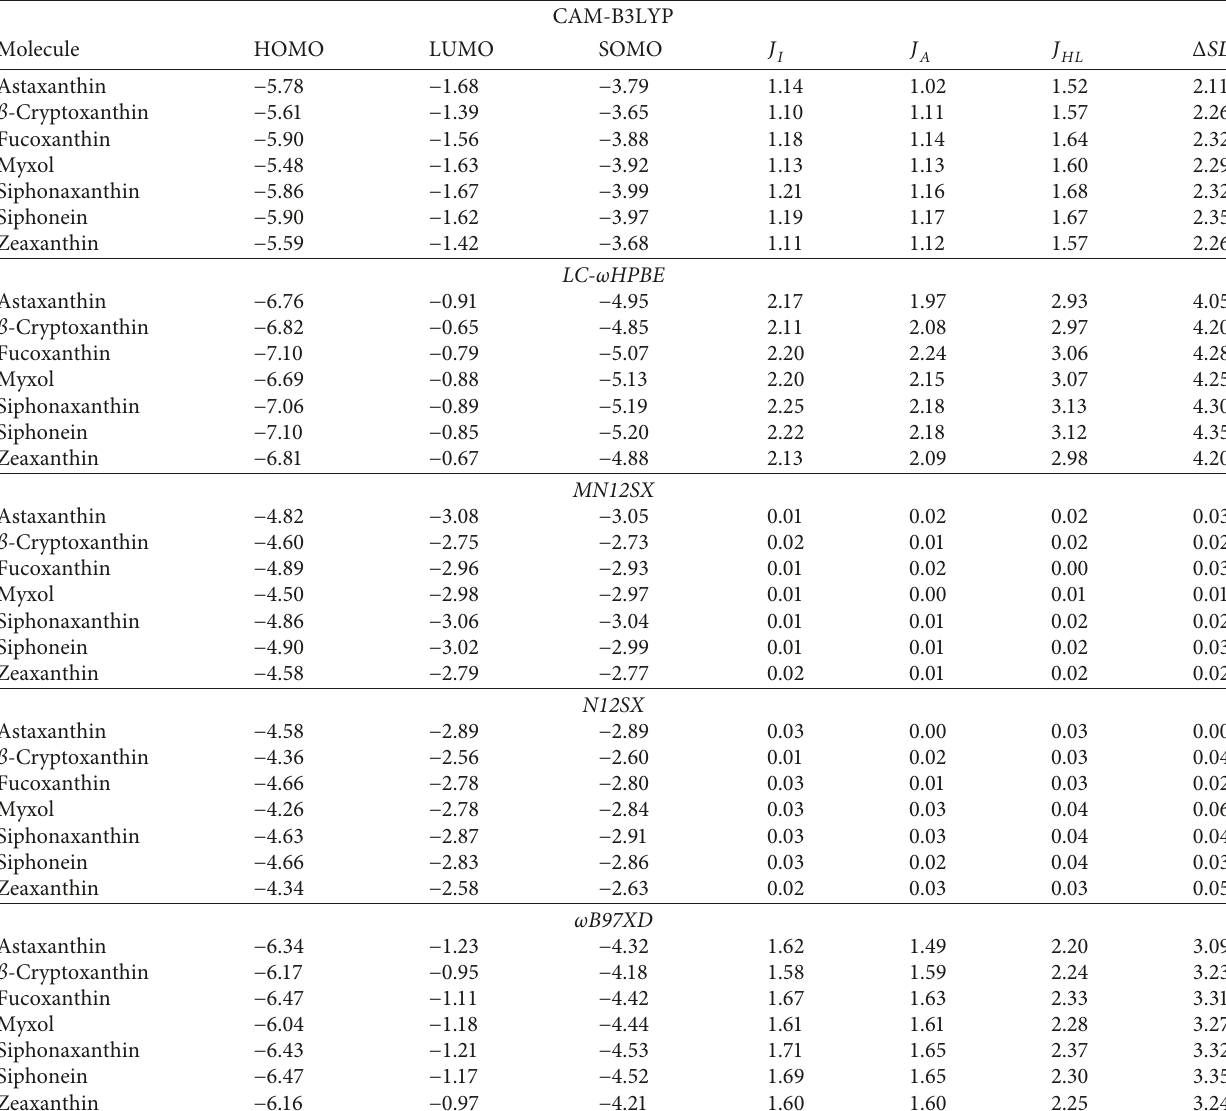
Table 2: HOMO, LUMO, and SOMO orbital energies (in eV) and the KID-related descriptors obtained with the five density functionals, the Def2TZVP basis set, and methanol as the